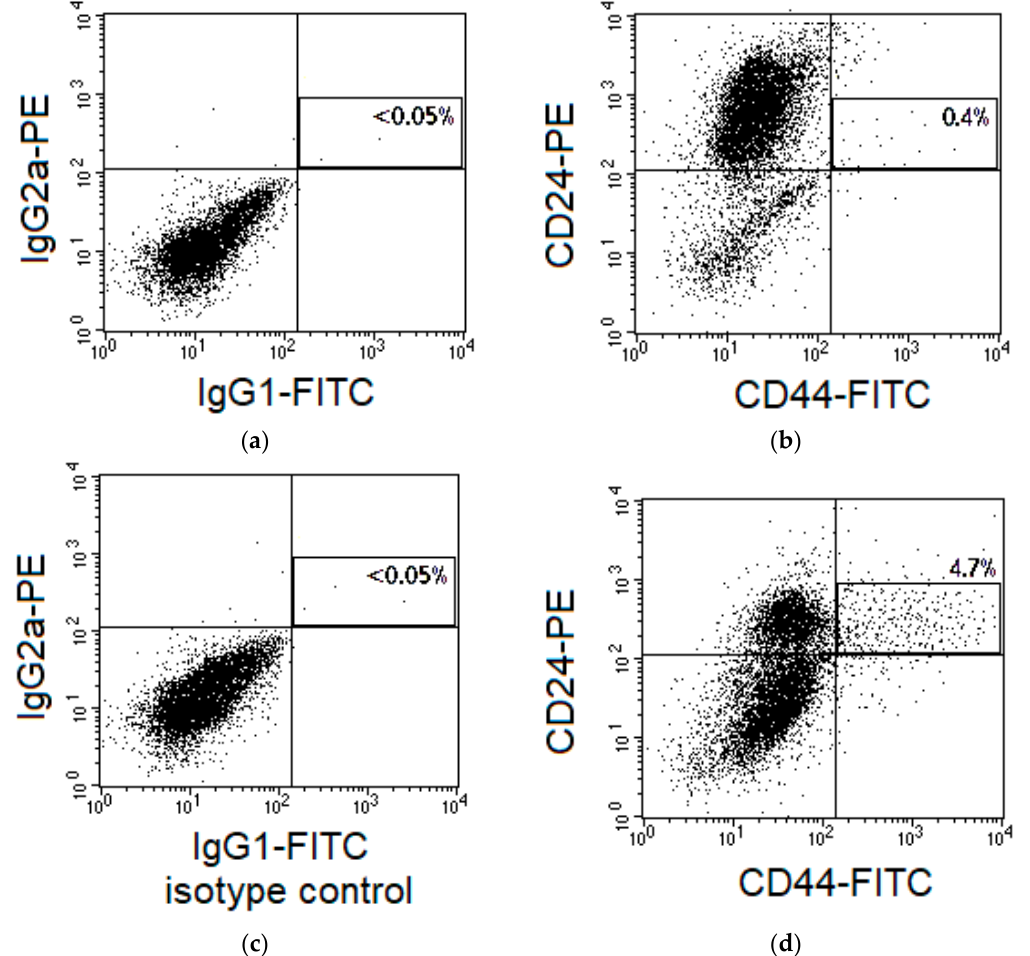
Figure 14. Representative dot plots for fluorescence of cervical cells from two patients with CC in the control of nonspecific binding ( a , c ) and after staining with antibodies to CD44 and CD24 ( b , d ) labeled with fluorescein isothiocyanate (FITC) and PE. Cases with different expressions of CD24 in the main part of cells and different proportion of CD44 + CD24 low cells are presented after gating for CD45 − Hoechst33342 (Ho342) + events. The region of CD44 + CD24 low cells is highlighted, and their percentage among CD45 - Ho342 + events is indicated.